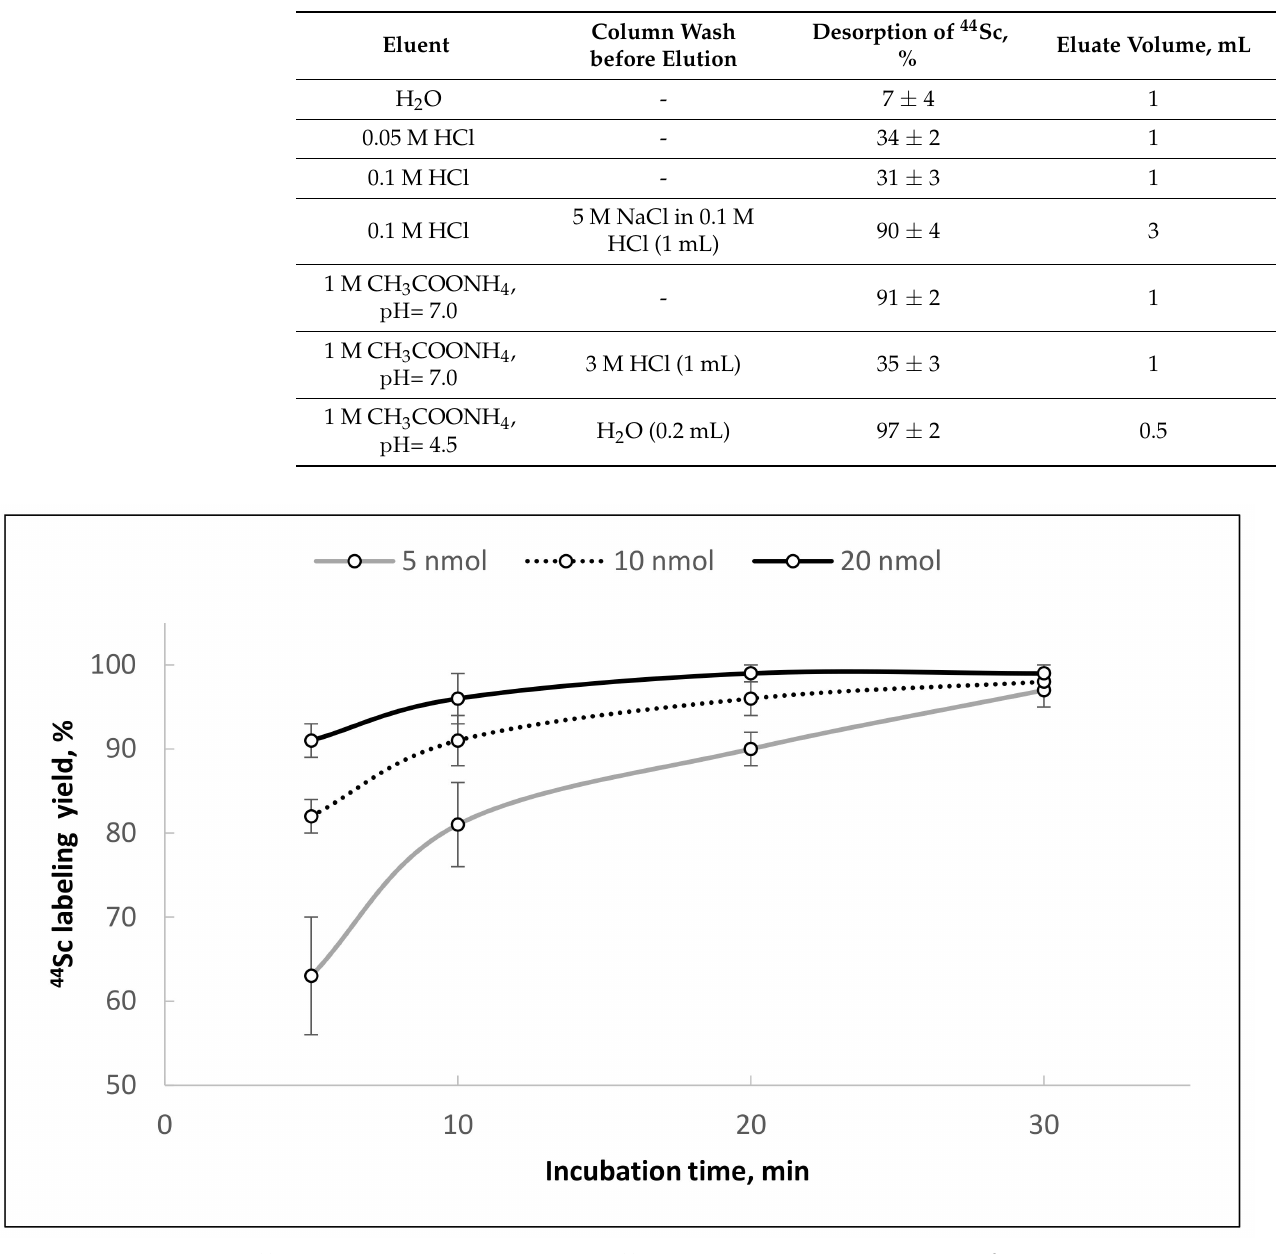
Figure 12. Kinetics of [ 44 Sc]Sc-PSMA-617 formation using 44 Sc after reformulation with Presep ® PolyChelate + TK221 reformulation and different precursor amounts (convective heating, 95 ◦ C, V = 1.0 mL, pH =